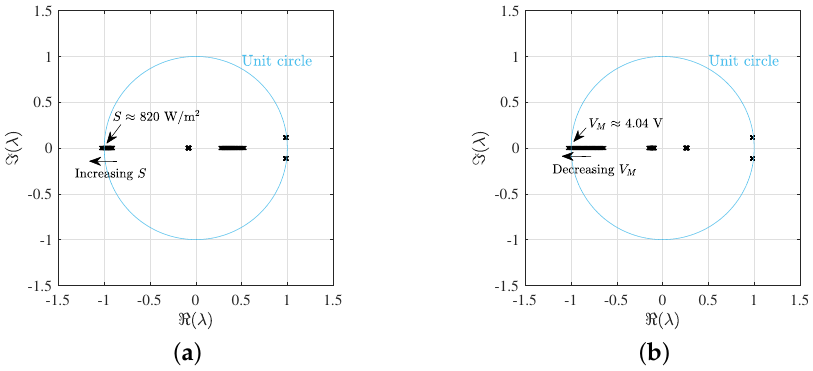
( 500,1000 ) W/m 2 , V M = 4 V, ∈ 2 , Θ = 25 ◦